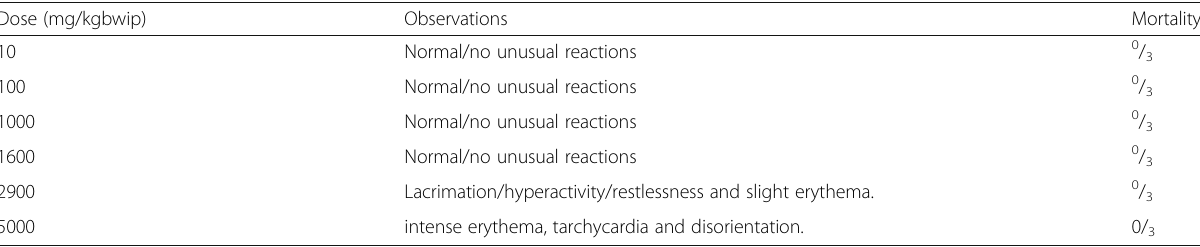
Table 7 Acute toxicity profile of Crude methanol extract of Zingiber officinale in rat Dose